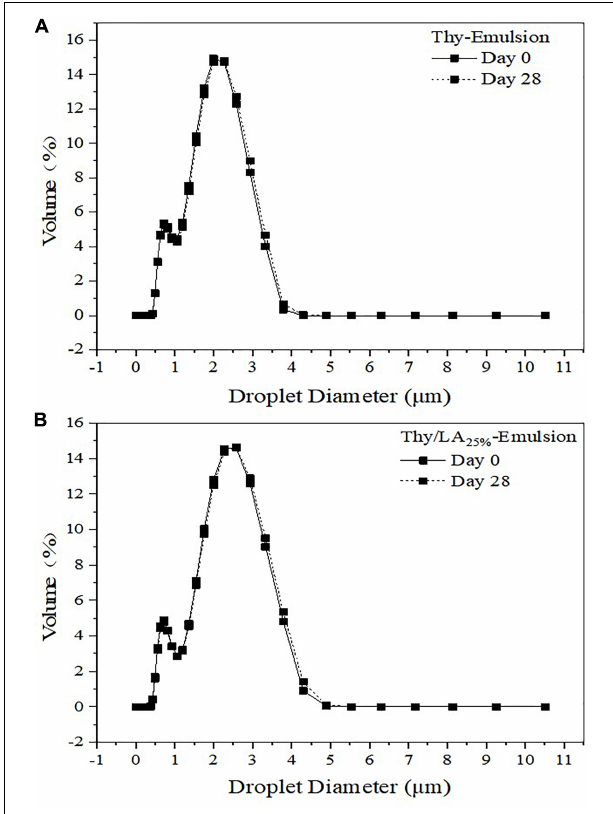
FIGURE 4 | Droplet size distributions in the volume of Thy-Emulsion (A) and Thy/LA 25% -Emulsion (B) . The solid line represents the 0th day, and the dashed line represents the 28th day. n = 3.